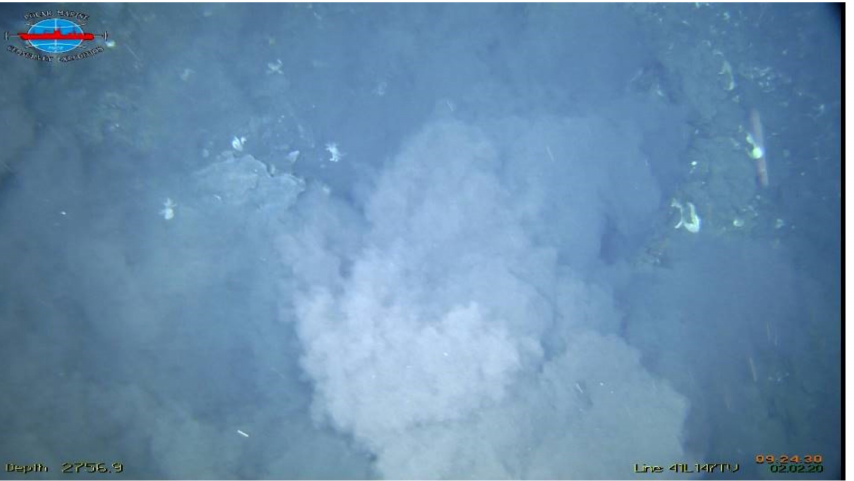
Figure 11. Venting black smoker chimneys, sulfide ores, and hydrothermal fauna. Koralovoye field. A meridional fault was revealed within the field, with a depth of about 30 m with steeply dipping, almost vertical sides. Outcrops of hydrothermal formations and metallif- erous sediments were observed in the walls of the